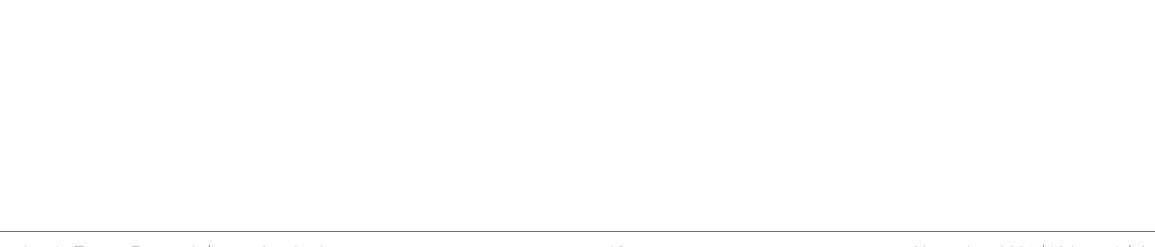
Frontiers in Energy Research |